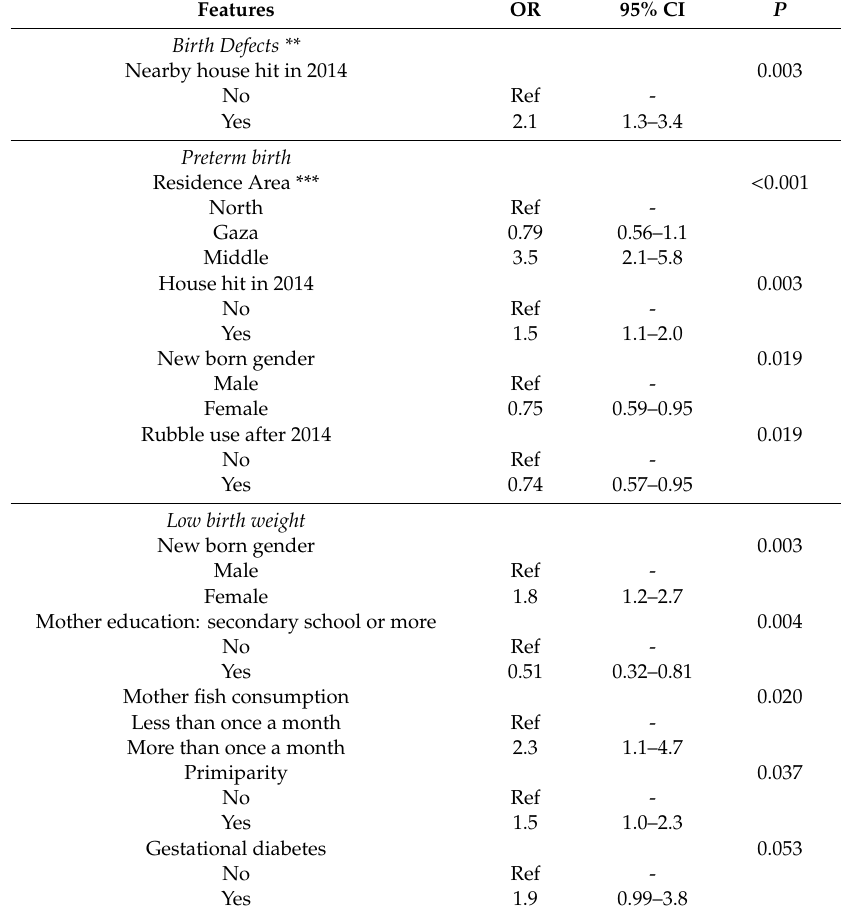
Table 3. Association between singleton babies with birth defects, preterm and of low birth weight at term and babies’ and mothers’ characteristics, evaluated by multivariable logistic regression analysis